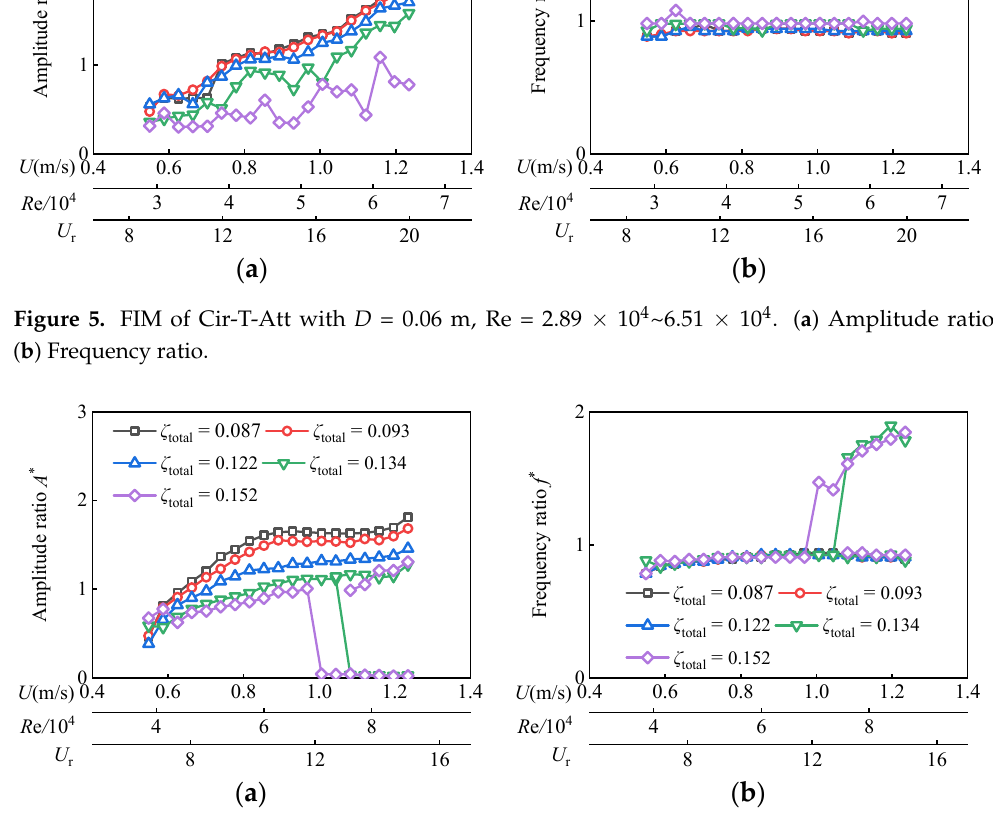
Figure 6. FIM of Cir-T-Att with D = 0.08 m, Re = 3.86 × 10 4 ~8.67 × 10 4 . ( a ) Amplitude ratio. ( b ) Frequency ratio.